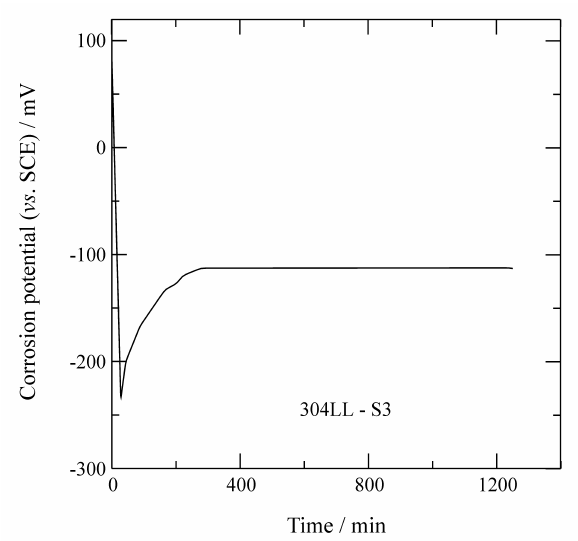
Figure 8. Corrosion potential E corr variation with immersion time in 3.5% NaCl solution for 304LL steel with S4 surface finish.